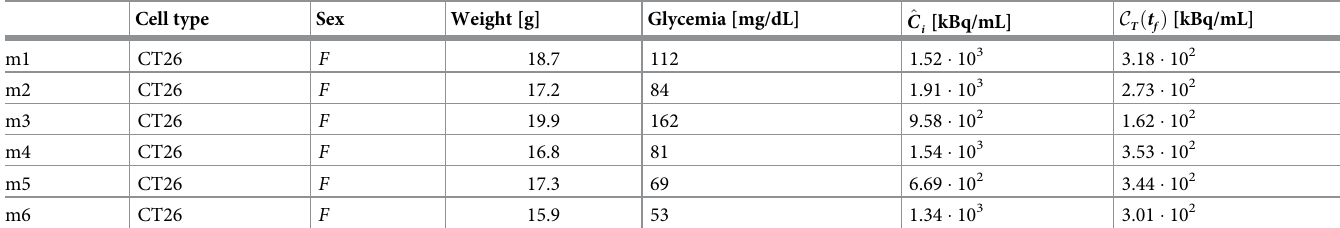
For each mouse the table shows: type of cell line, sex, weight (g), glycemia (mg/dL), maximum value of the IF denoted as ^ C concentration of the cancer tissue C